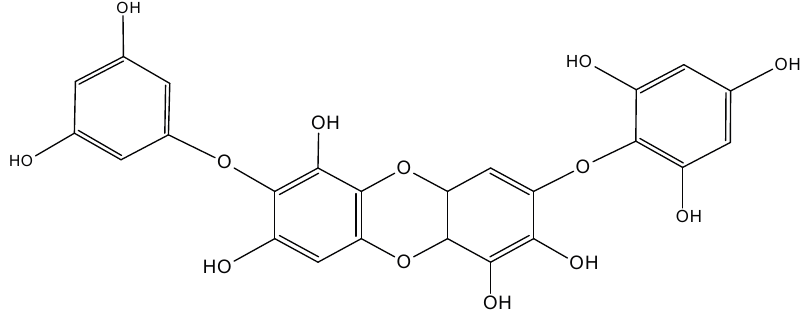
Figure 25. Diphlorethohydroxycarmalol (DC, 63 ).